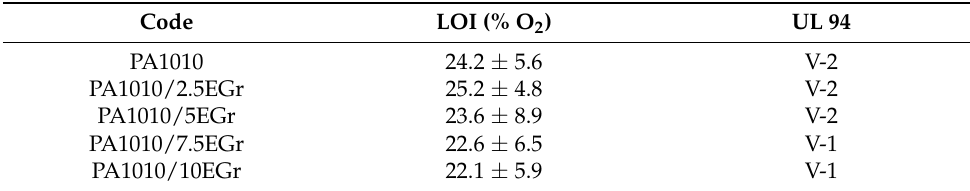
Table 9. Smoke parameters obtained with CCT on the PA1010 and EGr